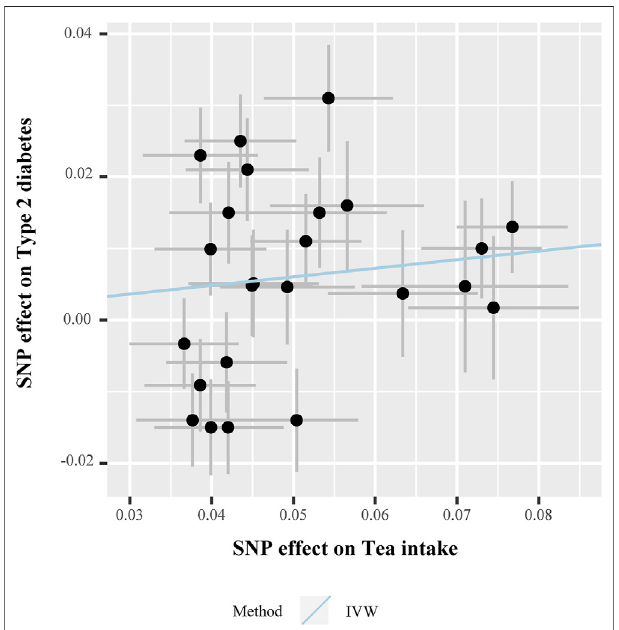
FIGURE 3 | Scatter plot for the SNP effect size estimate. Relationship between the SNP effect size estimate of tea intake ( x -axis) and the corresponding effect size estimate of T2D ( y -axis). Each black dot represents a valid instrumental SNP. A total of 24 SNPs were analyzed. The horizontal and vertical short lines through the dots represent the 95% CIs of the SNP effect on tea intake and T2D effect, respectively. The slope of fi tted lines (blue line) represents the estimated causal effect of tea intake on T2D using the IVW method. Abbreviations: SNPs, single-nucleotide polymorphisms; T2D, type 2 diabetes; IVW, inverse variance-weighted method.